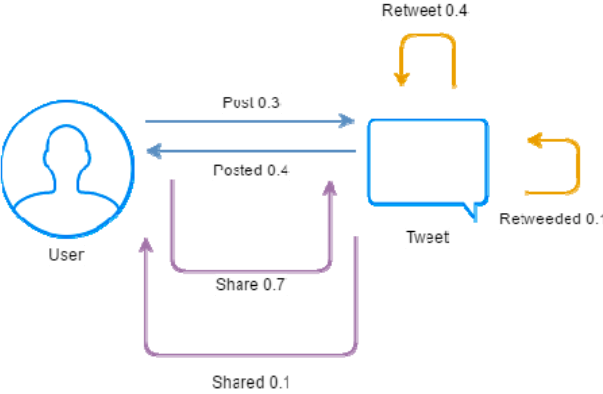
Figure 2. An example user-post graph with different edge weights for posting, sharing, and retweeting actions.